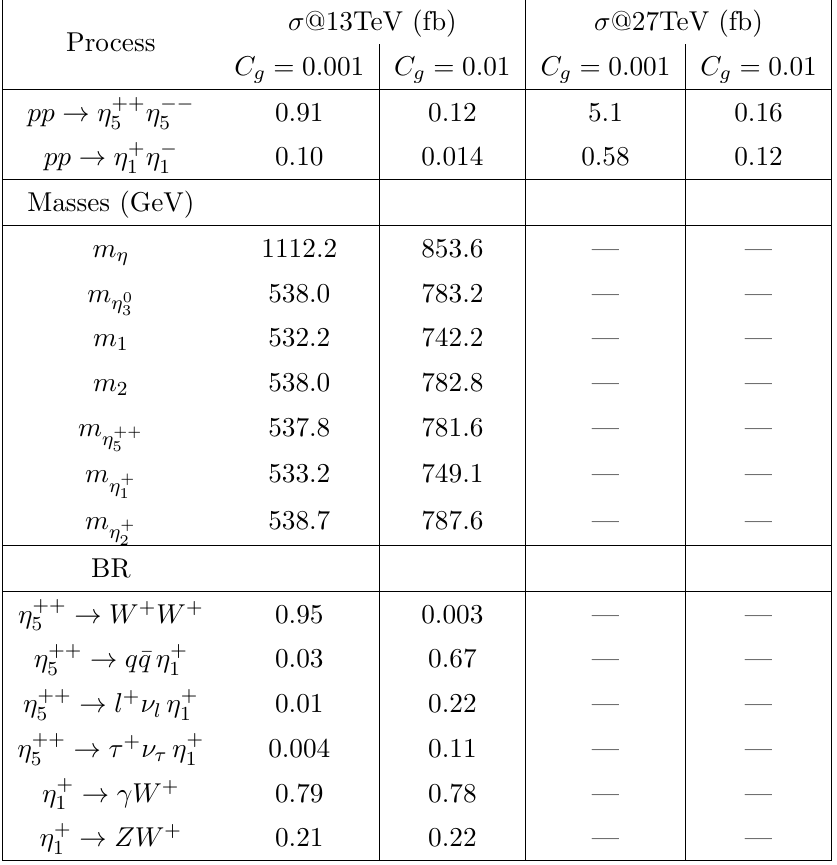
Table 4 . Leading production cross-sections at the LHC for points with C g = 0 : 001 and 0 : 01 ( l = e; (cid:22) ). The BRs refer to the (cid:17) ++ into (cid:17) + 1